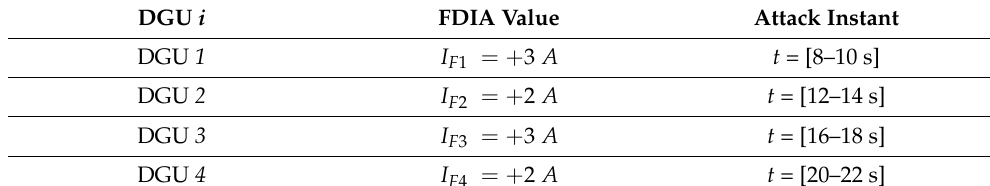
Table 7. Sequential current FDIA parameters.